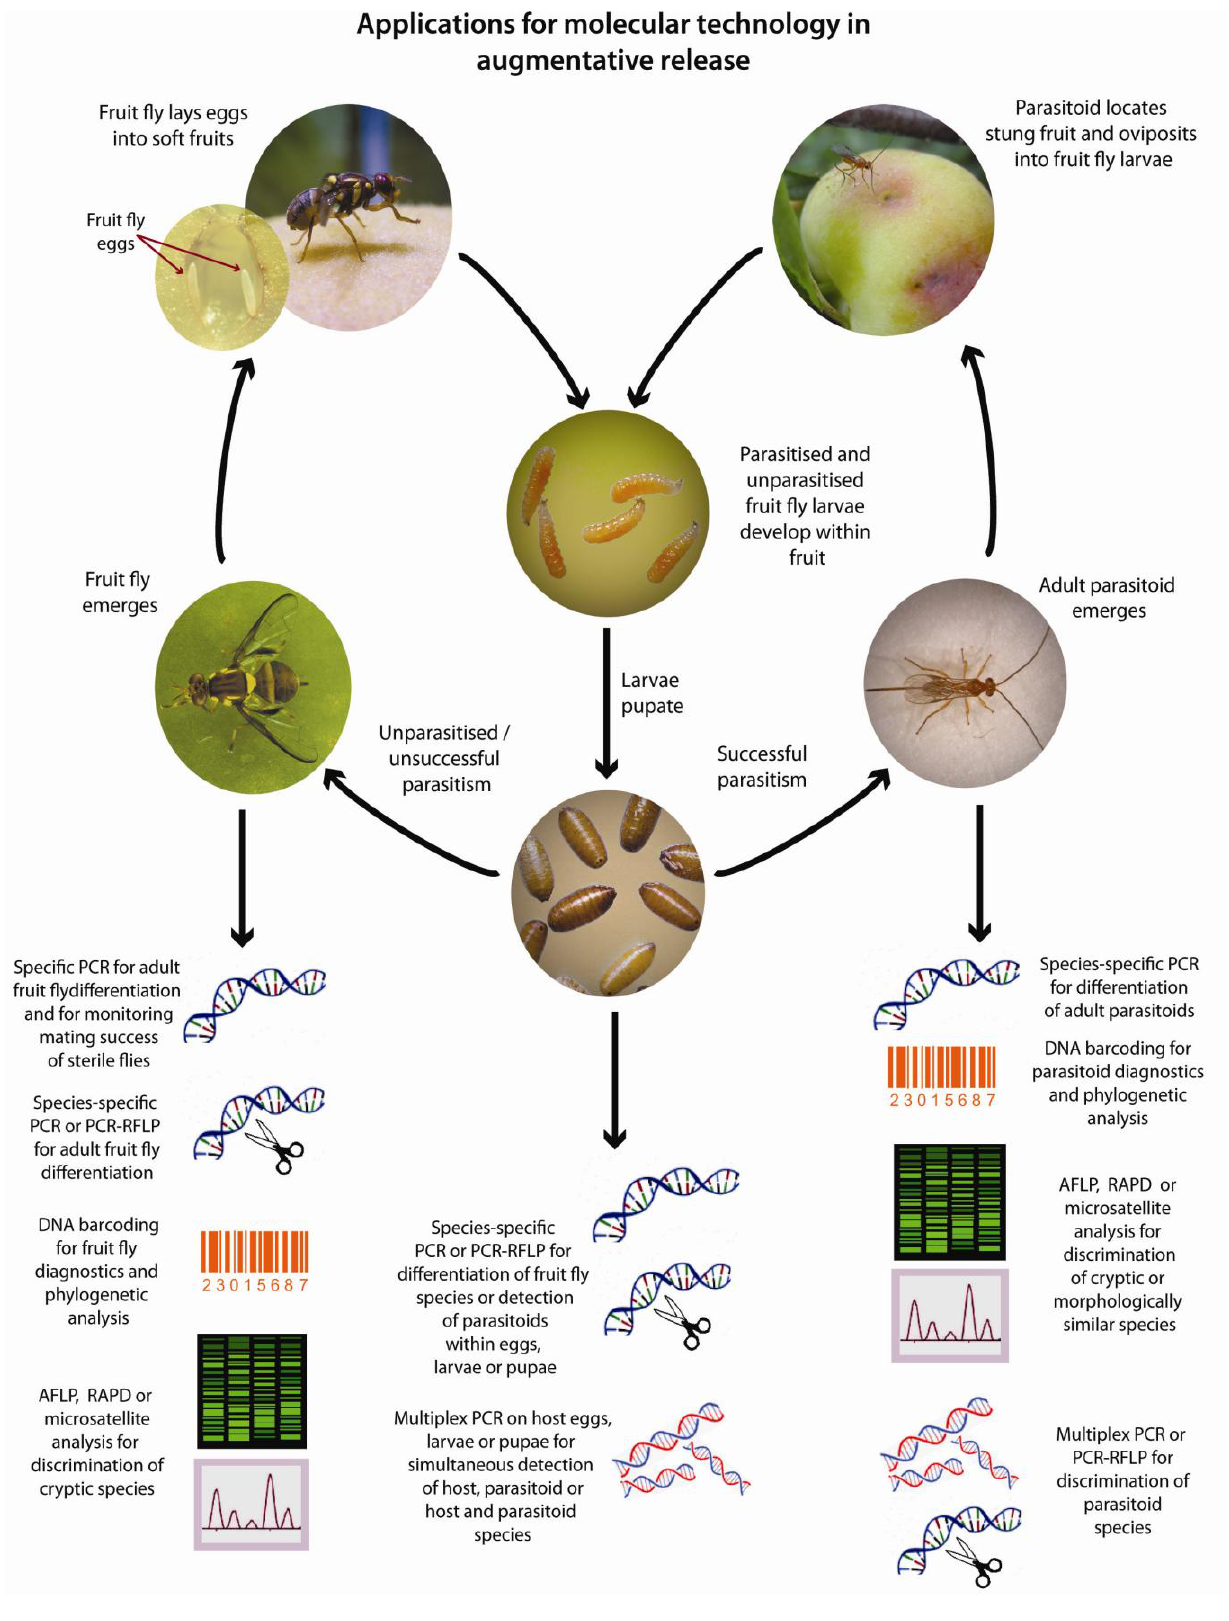
Figure 2. Applications for molecular techniques in the augmentative release of parasitoid wasps against tephritids. (Photographs by Max Hill and Lowan Turton, modified with permission ©NSW